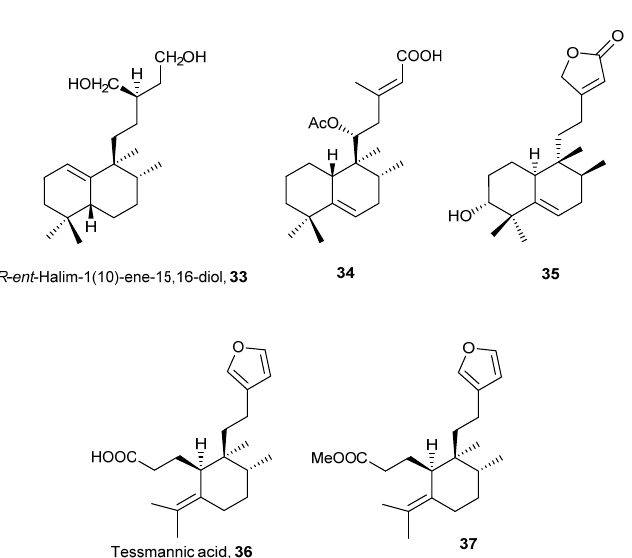
Figure 9. Antibacterial halimanes from plants Table 5. Natural sources, activities of antibacterial halimanes from plants